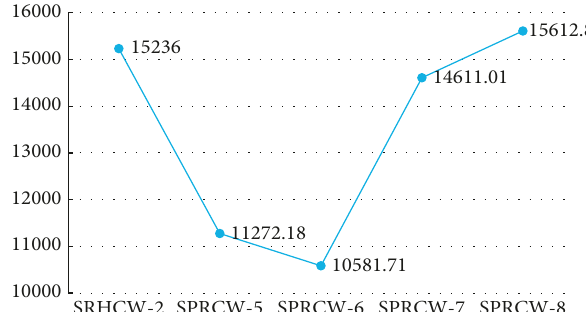
Figure 14: Comparison of accumulated energy dissipation.